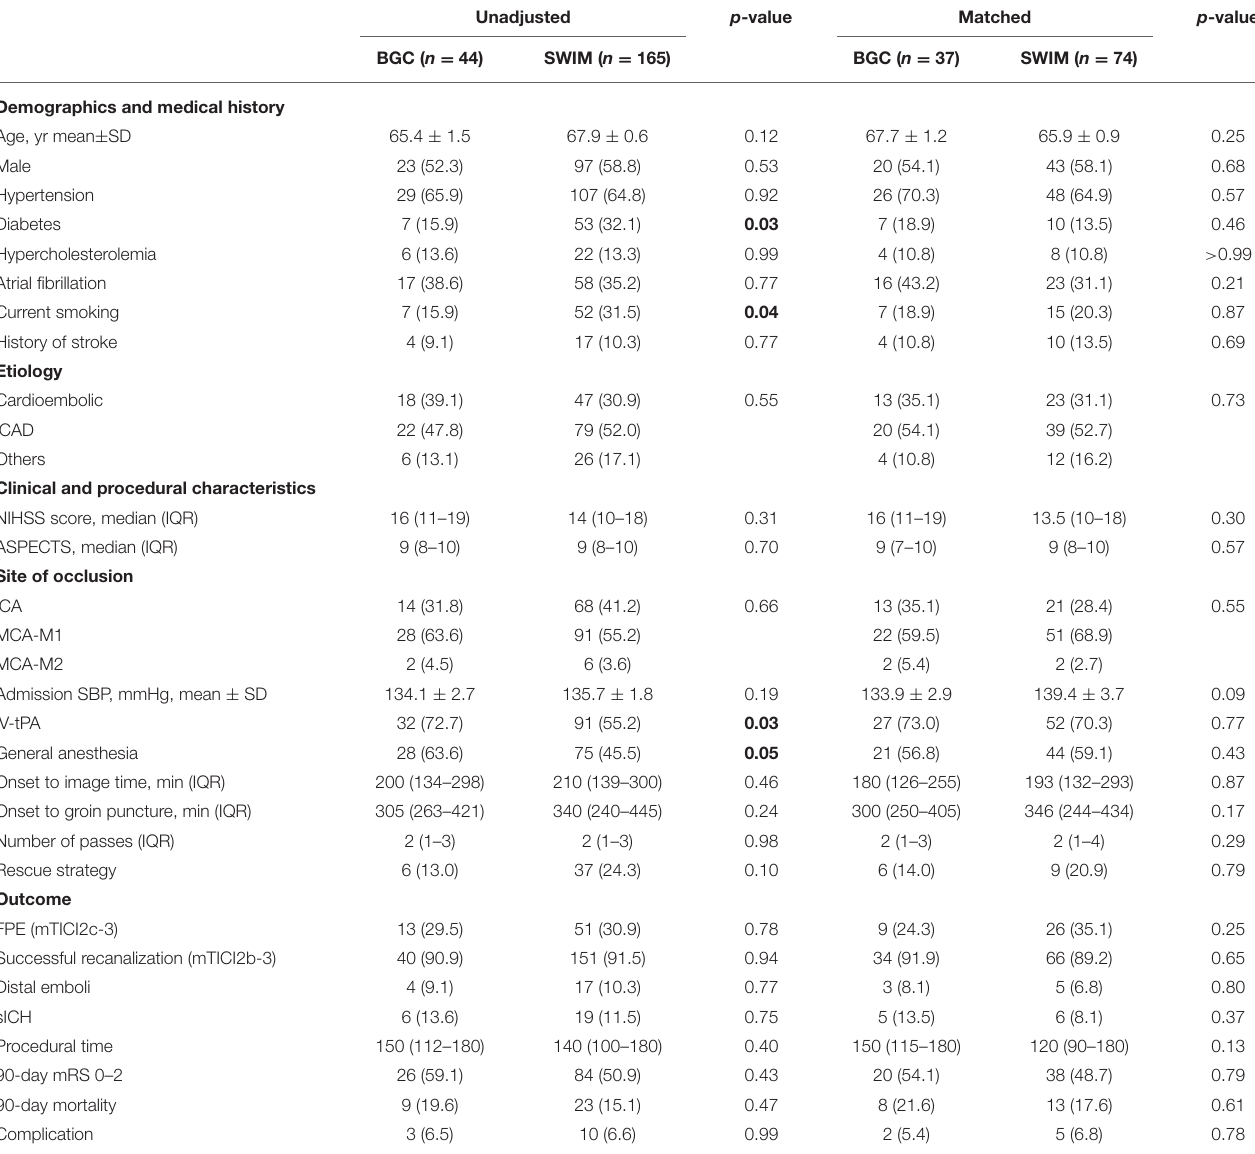
TABLE 1 | Demographic, clinical, procedural characteristics, and outcomes according to first-line treatment strategy (BGC vs. non-BGC) in the overall population and the matched cohort. Unadjusted p -value Matched p -value BGC ( n =